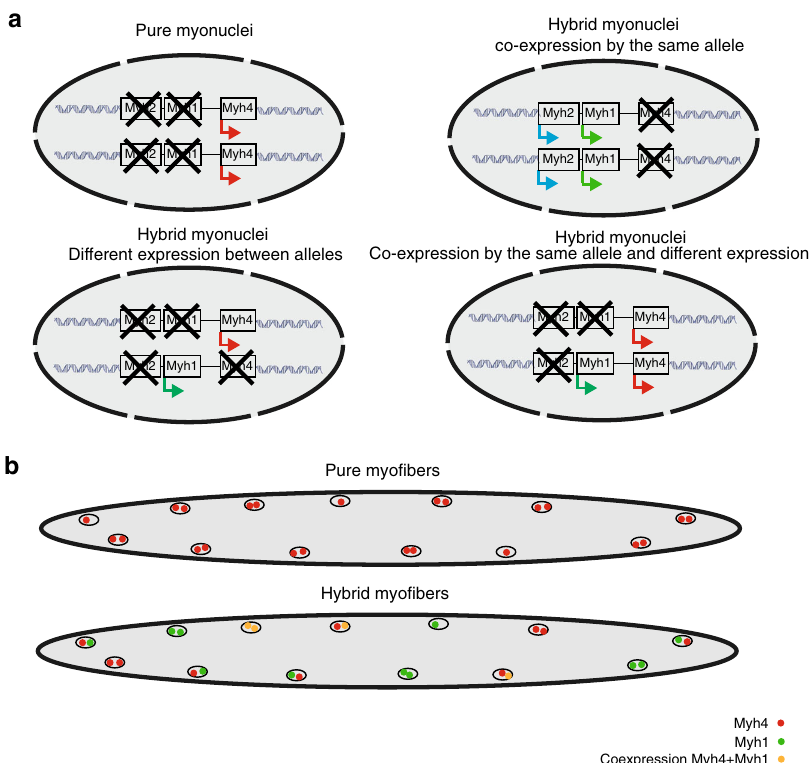
Fig. 8 Diagram of Myh expression in pure and hybrid myonuclei and myo fi ber. a Diagram showing the different possibilities of Myh isoforms expression in a myonucleus from the results of our experiments. b Diagram showing the different possibilities of Myh isoforms expression in a myo fi ber from the results of our